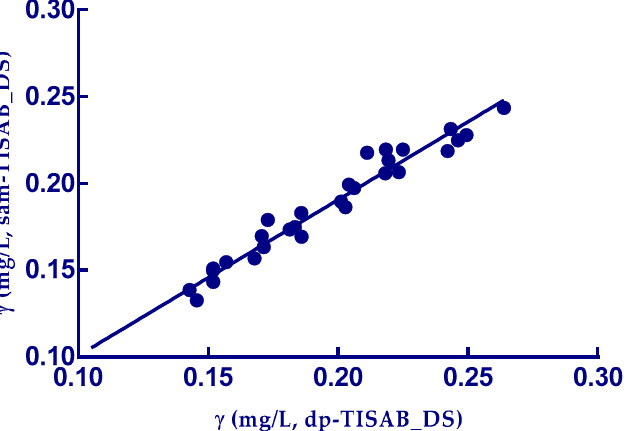
Figure 4. Pearson’s correlation analysis between the fluoride content in various kinds of white and red wines obtained using dp-TISAB_DS and sam-TISAB_DS ( p <